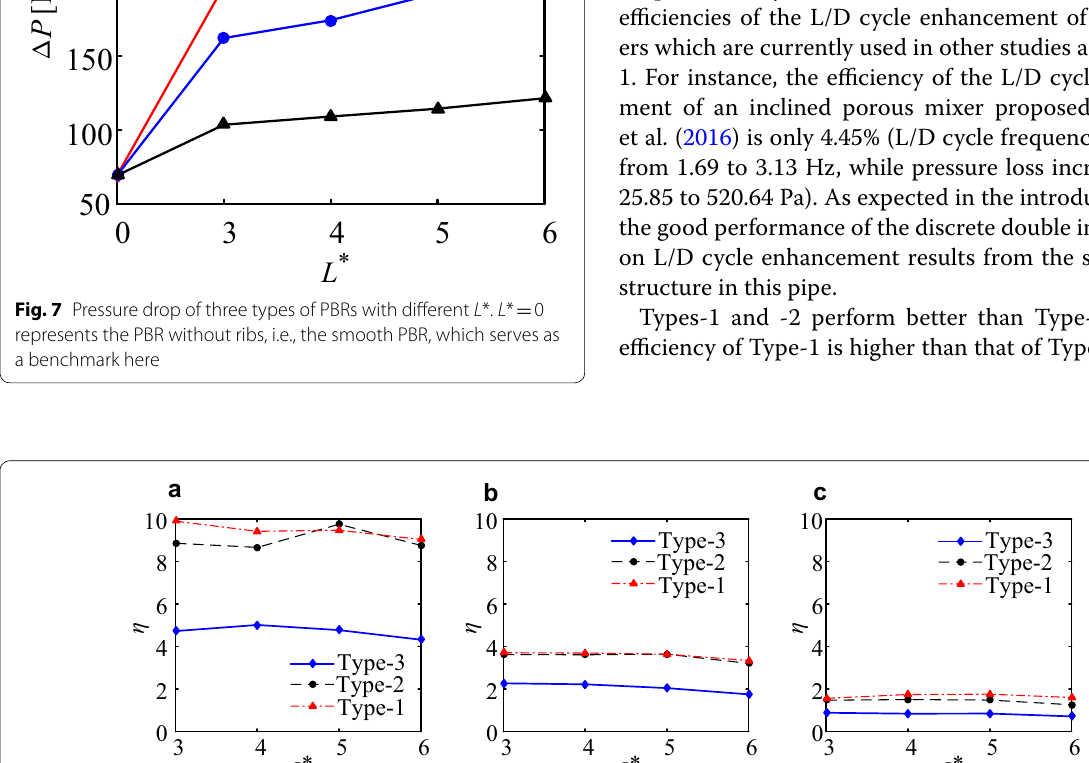
Fig. 8 The efficiency of L/D cycle enhancement of three types of PBRs with different L *. The incident light intensities are a 375 μmol m − 2 s − 1 , b 800 μmol m − 2 s − 1 and c 1200 μmol m − 2 s −